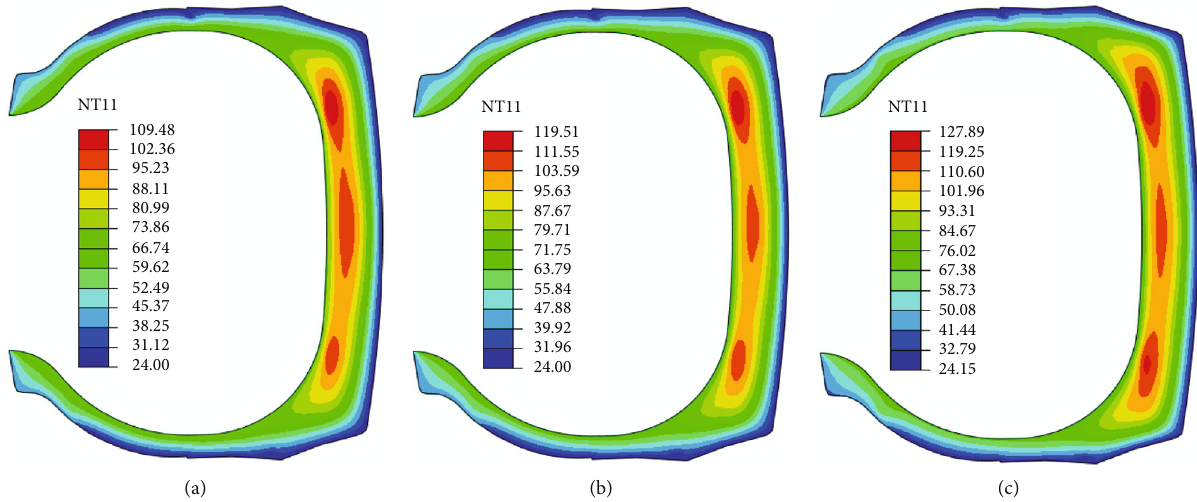
Figure 14: Temperature fi eld distribution of a tire at a speed of 15km/h: (a) 0.55MPa in fl ation pressure and 46667 kg load (working Condition (4)), (b) 0.6MPa in fl ation pressure and 55000 kg load (working condition (8)), and (c) 0.5MPa in fl ation pressure and 63333kg load (working Condition